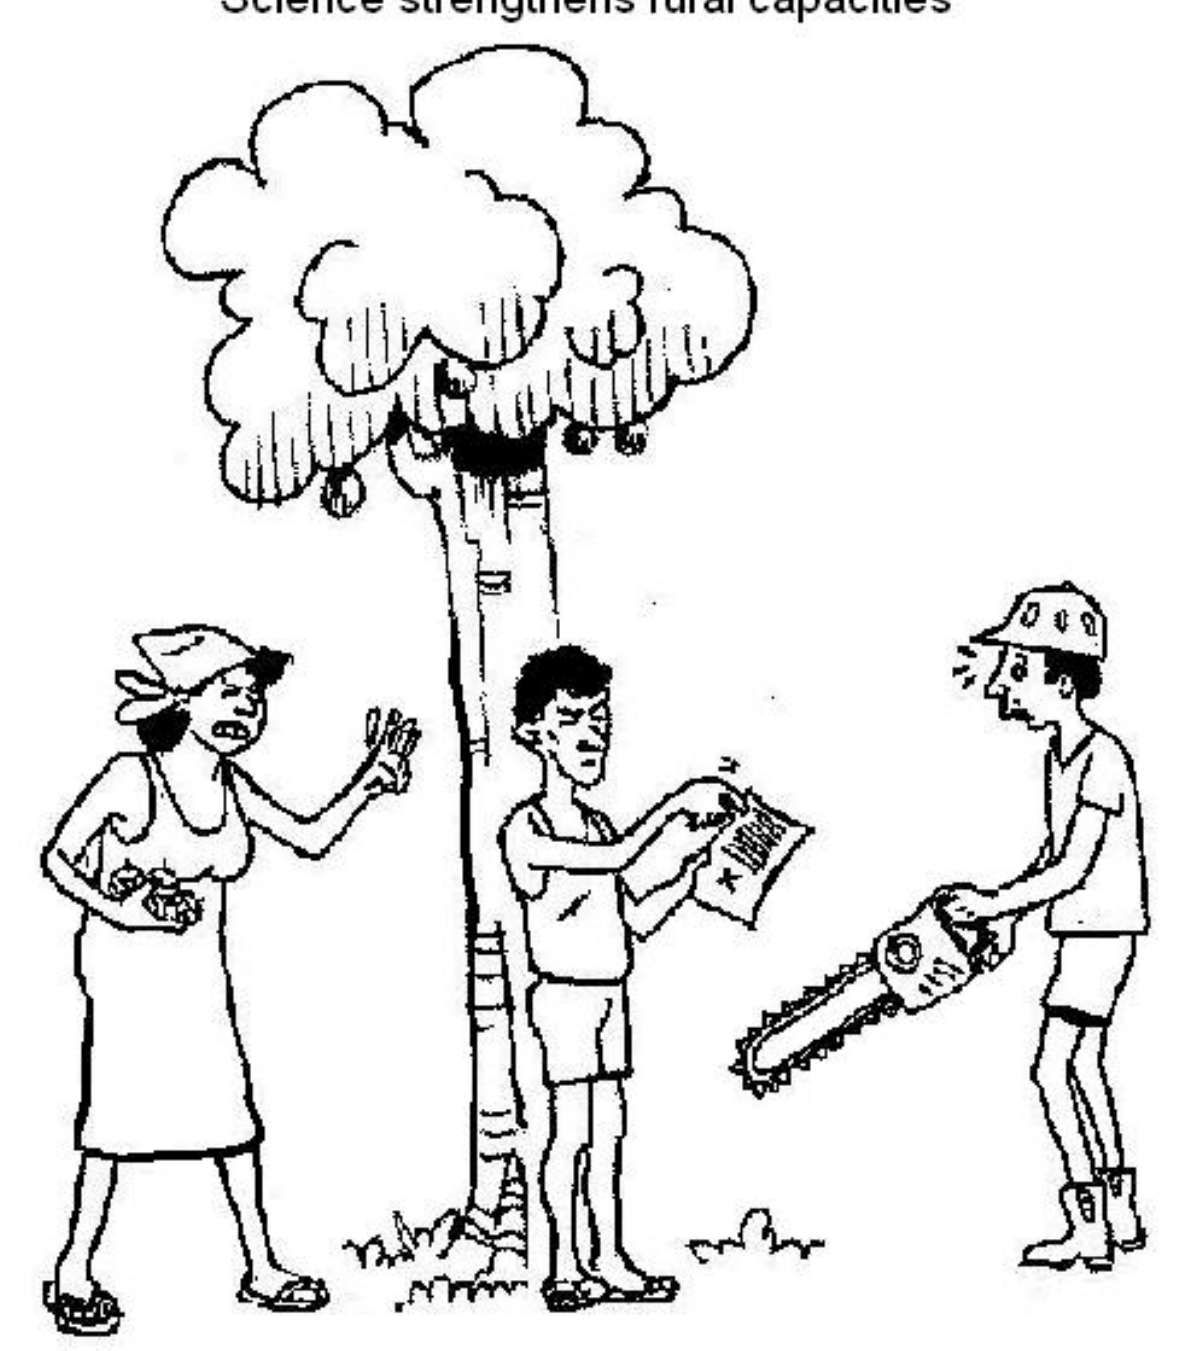
Fig. 11. Families negotiate to conserve valuable fruit and medicinal oil